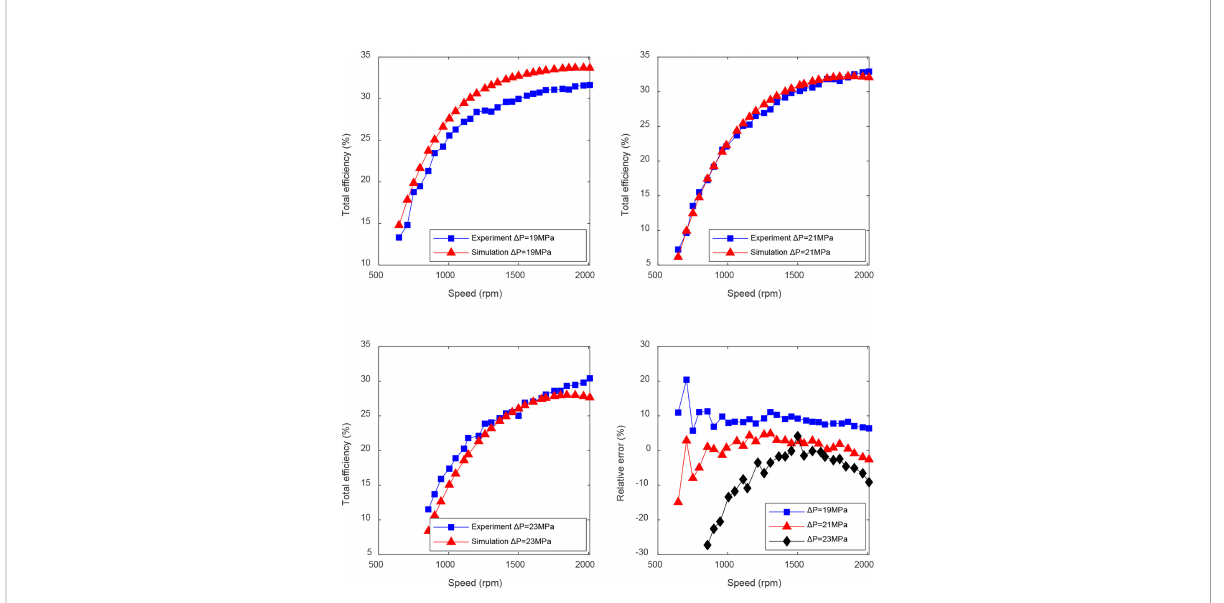
FIGURE 12 The simulation and experimental comparison of direct